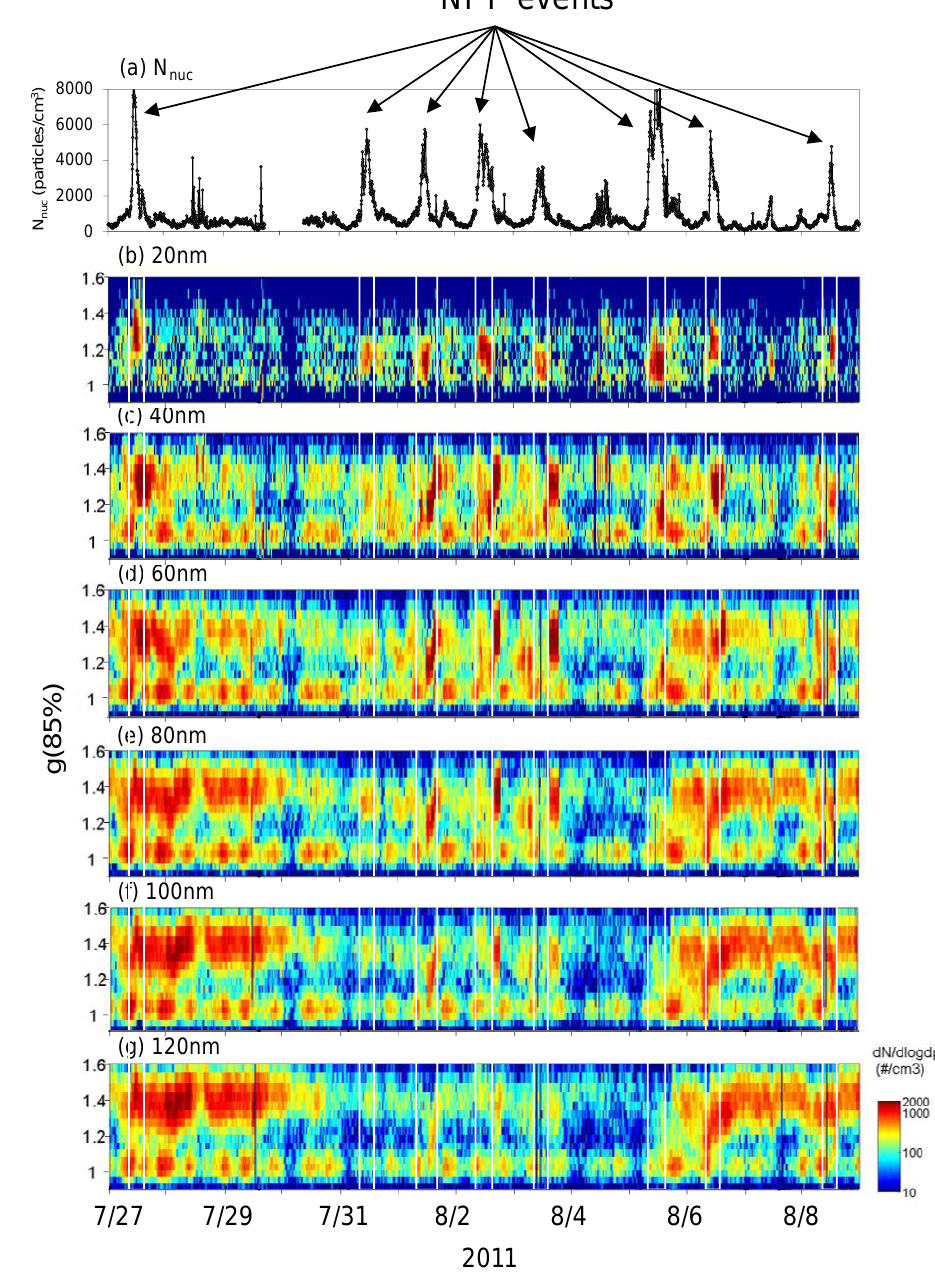
Figure 3. (a) N nuc and (b–g) temporal evolutions of the number concentrations of atmospheric particles as a function of the hygroscopic growth factor at 85% RH [ g (85%)] at the measurement site between 27 July and 8 August 2011. Dry particle diameter ( D p ) increases from (b) 20nm to (g) 120nm with a 20nm increment. Eight new particle formation (NPF) events were identified on 27 and 31 July, and 1–3, 5, 6, and 8 August 2011, as marked by white